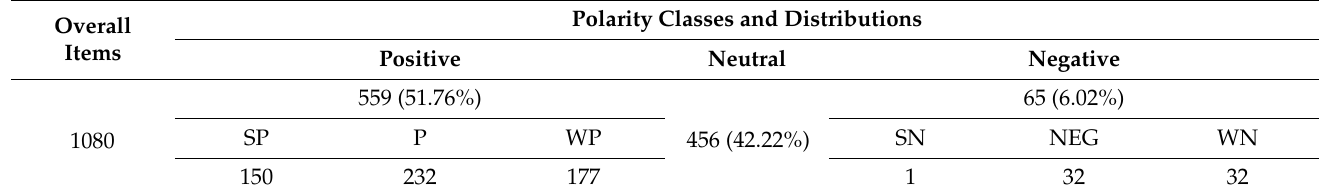
Table 3. Polarity distributions of the dataset using TextBlob.